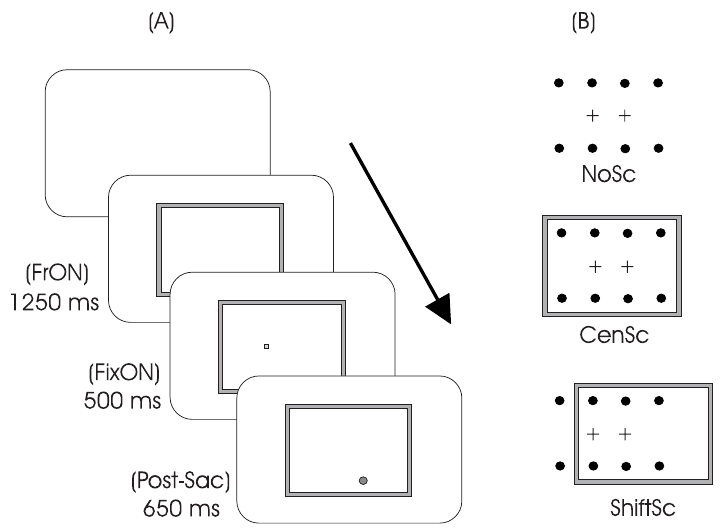
Fig. 1 – (A): Behavioral task adopted, illustrating one of the 48 possible conditions. In this condition, a gray frame (scene) appears on a black screen for 1250 ms while the monkey is free viewing (FrON period). Two periods of fixation then follow: the FixON (gazing on the FP) and the Post-Sac (gazing on the target). Between the FixON and Post-Sac periods, the Pre-Sac period was also analyzed (not shown). This interval consisted mainly of the latency for the onset of the SEM after the target was turned on. (B) illustrates the two possible FP positions (crosses), the eight possible target positions (upper and lower spots) and the three contexts of scene: context with no scene (NoSc), with centered scene (CenSc) and with shifted scene (ShiftSc). The square with rounded corners represents the border of a 21’’ monitor. The bold arrow represents the trial progression in